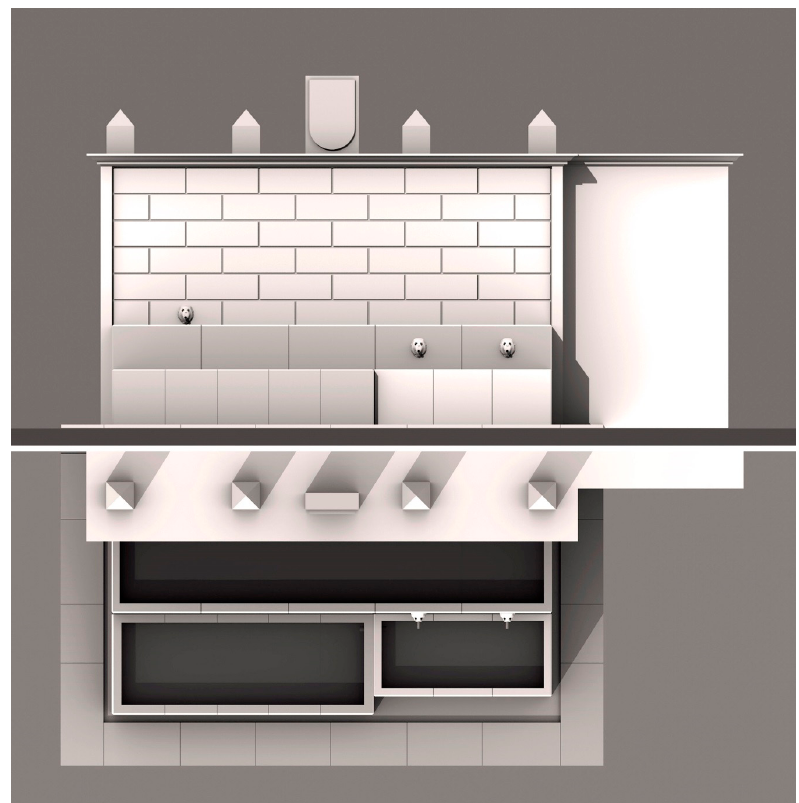
Figure 11. Proposal of the plan and elevation of the virtual reconstruction of the Magdalena fountain in Lugo. The image was provided by the authors.